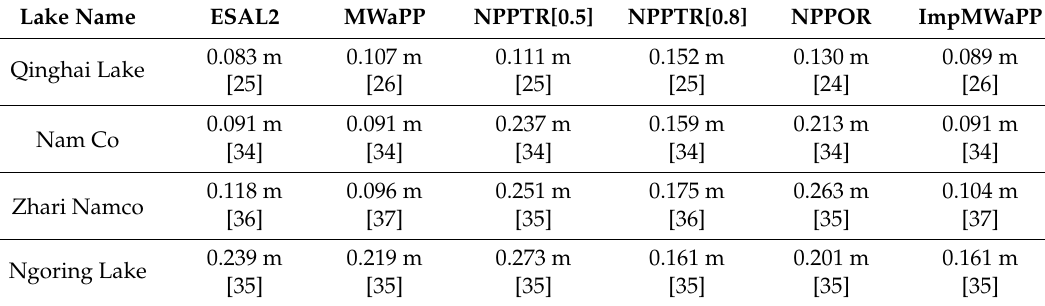
Table 4. RMSEs between Cryosat-2 time series and in situ data: no-ice